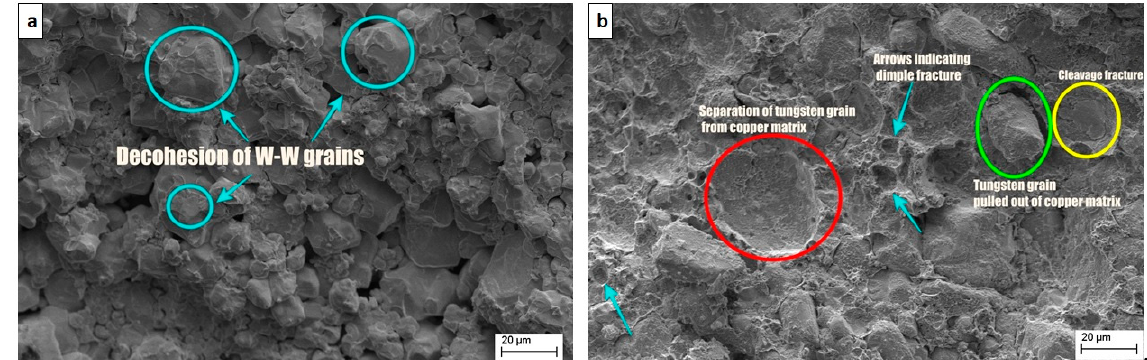
Figure 10. Image showing failure modes. ( a ) Base and ( b ) alloy with 25 wt.% nano-copper.